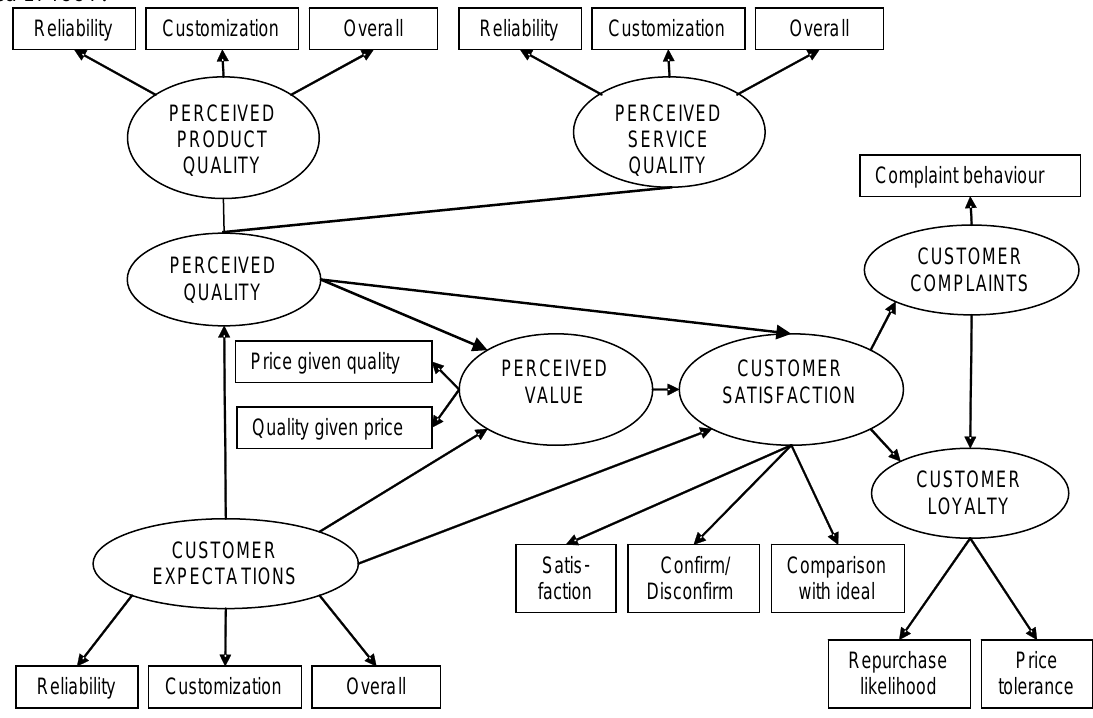
Figure 1: Expanded ACSI